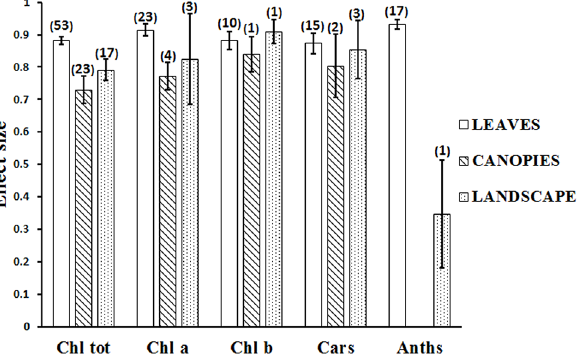
Fig 3. The mean effect size for pigment types at the scales of leaf, canopy and landscape. (The numbers of reported relationships found in the literature are shown in brackets, error bars represent 95% confidence